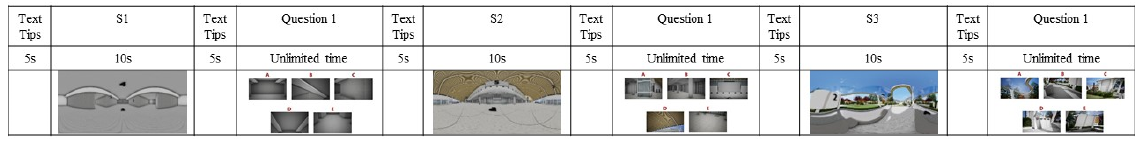
Figure 3. Experiment 2 process.